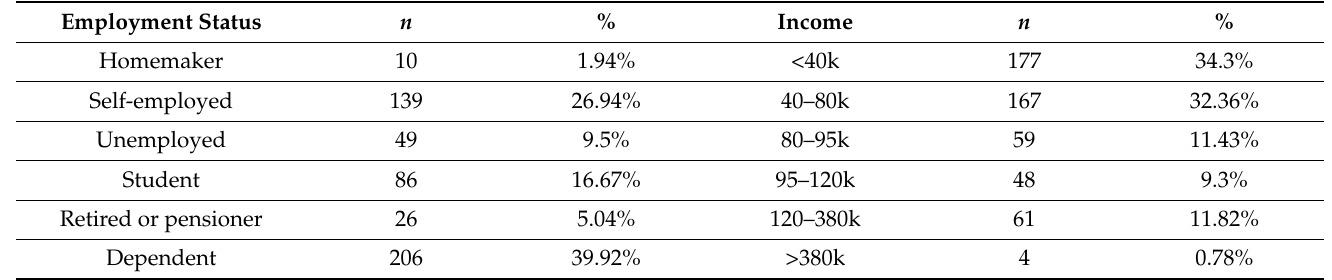
Table 3. Employment status and income